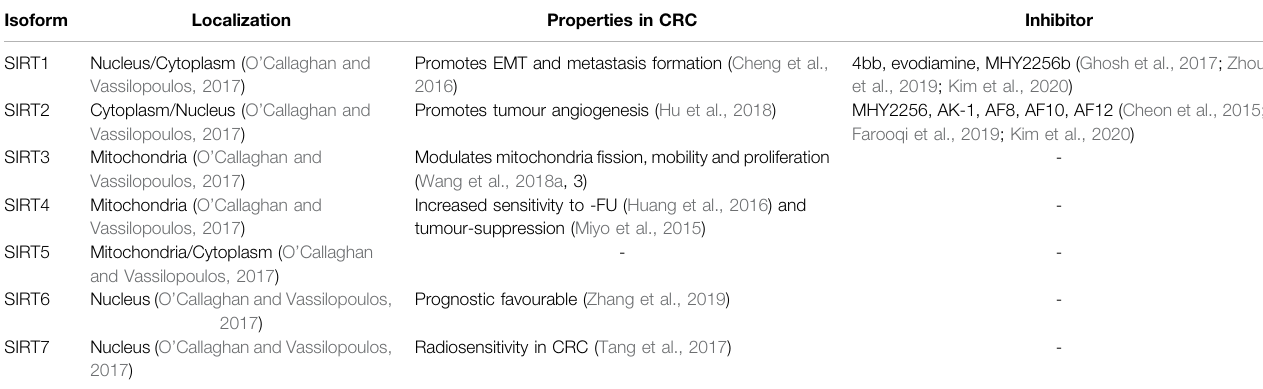
TABLE 3 | SIRT properties in